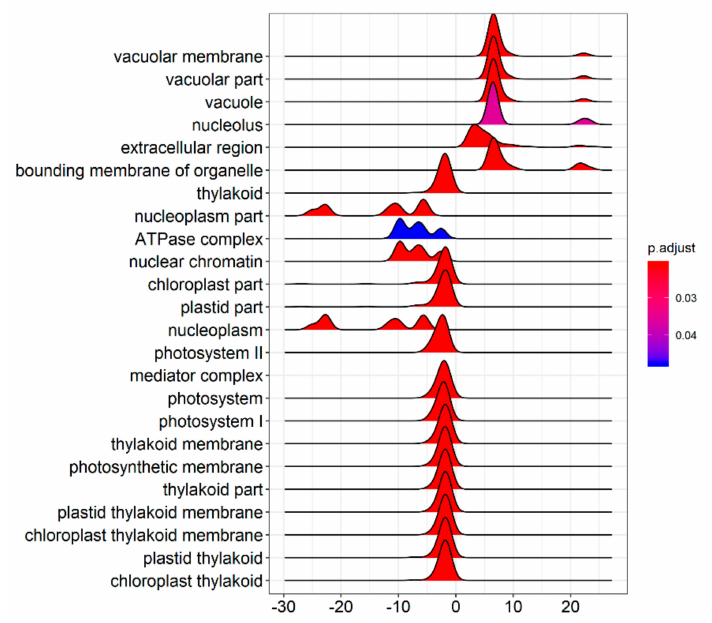
Figure 7. Gene set enrichment analysis of cell component distribution.